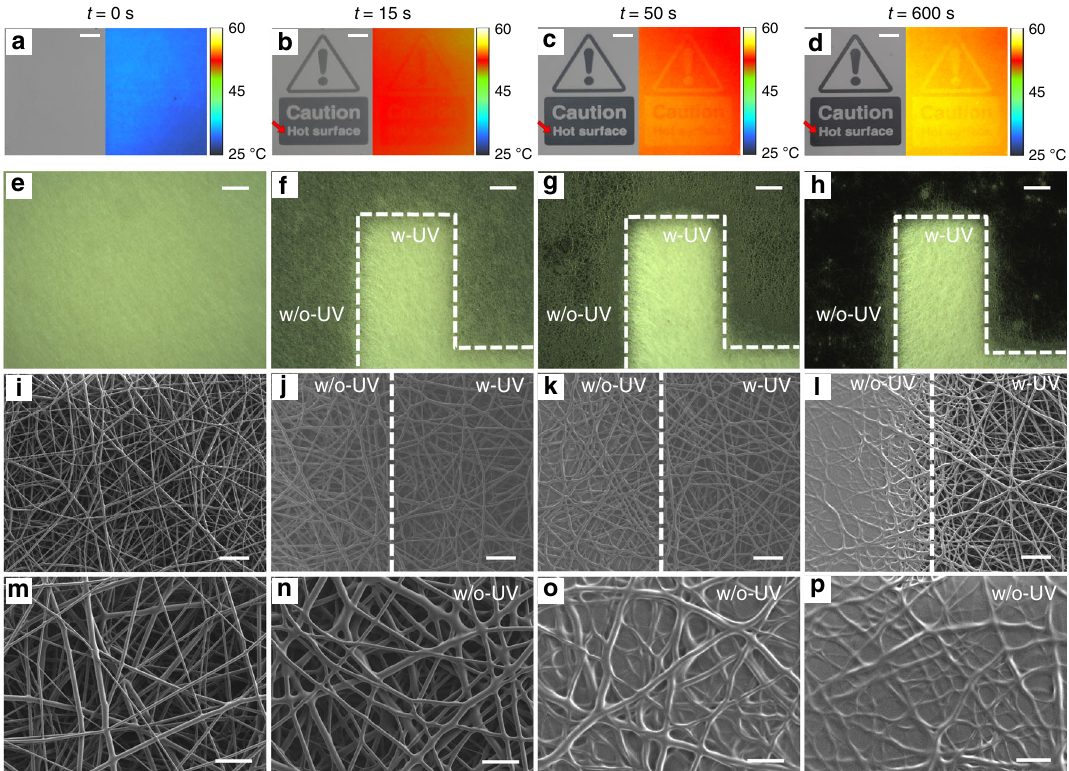
Fig. 2 Pattern activation and changing morphology. a Photographs (left) and thermal images (right) of fi brous samples after the second step of photo- programming. b – d Photographs and thermal images of the sample in a captured at different times during heating at 55 °C. The color scale in thermal images indicates the temperature of the sample. (Scale bars in ( a – d) : 5 mm). e – h Corresponding optical micrographs of a – d for a feature of the letter “ H ” in the sign “ Hot ” (red arrow in ( b – d )). w-UV (w/o-UV) indicates the area of the sample exposed (unexposed) to UV light during the second step of photo- programming. Scale bars, 200 μ m. i – l Corresponding SEM micrographs at the interface between the UV exposed (w-UV) and the unexposed areas (w/o- UV), collected at the various time points. Scale bars, 20 μ m. m – p Higher magni fi cation view of the areas shown in ( i – l ), that are not exposed to UV light during the second step of photo-programming. Scale bars, 10 μ